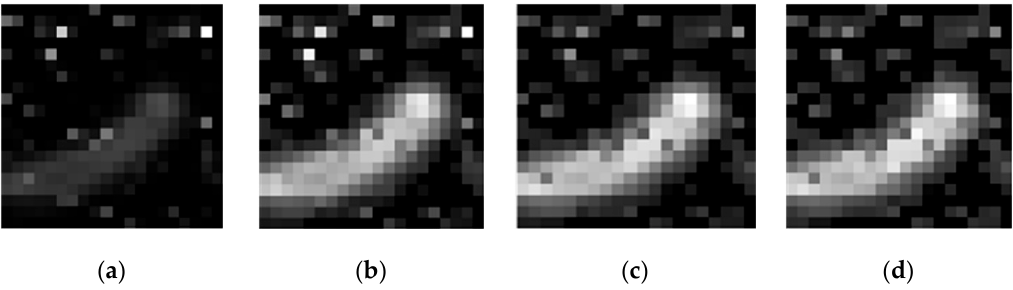
Figure 3. N points represent the symmetrical points near the peak. The four images are, respectively, the result of extracting the N values around the peaks. In Figure ( a ), N = 1. In Figure ( b ), N = 4. In Figure ( c ), N = 8. In Figure ( d ), N = 12.